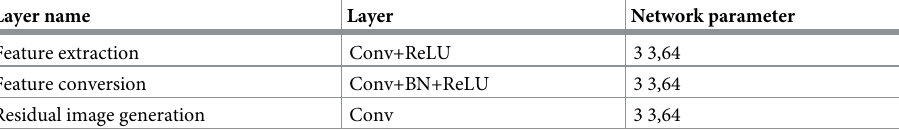
Table 1. The layers for DnCNN